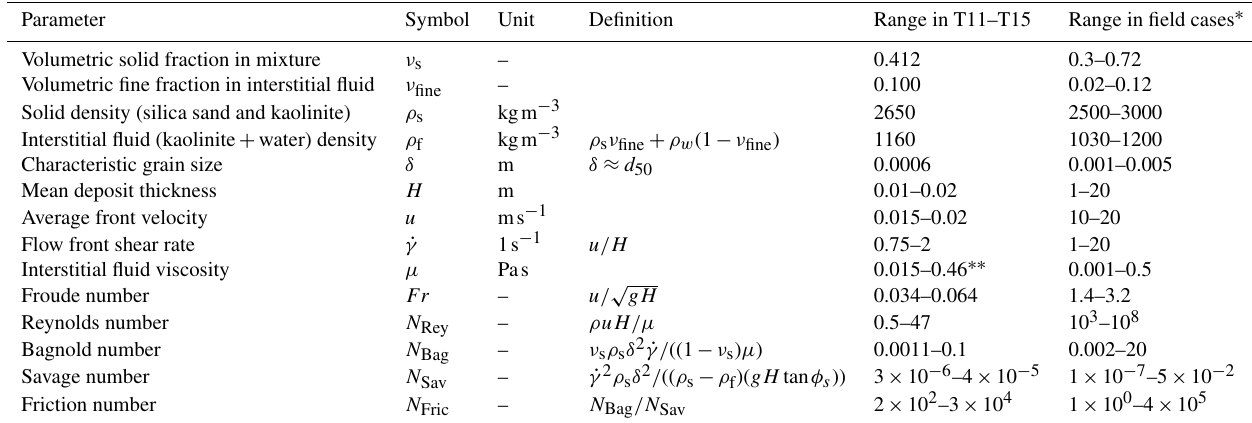
Table 2. Parameter ranges in the laboratory experiments (T11–T15) and in documented field cases.